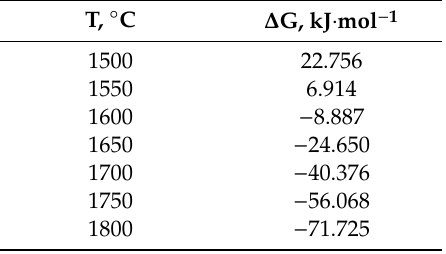
Table 4. Thermodynamic calculations for Equation (19).